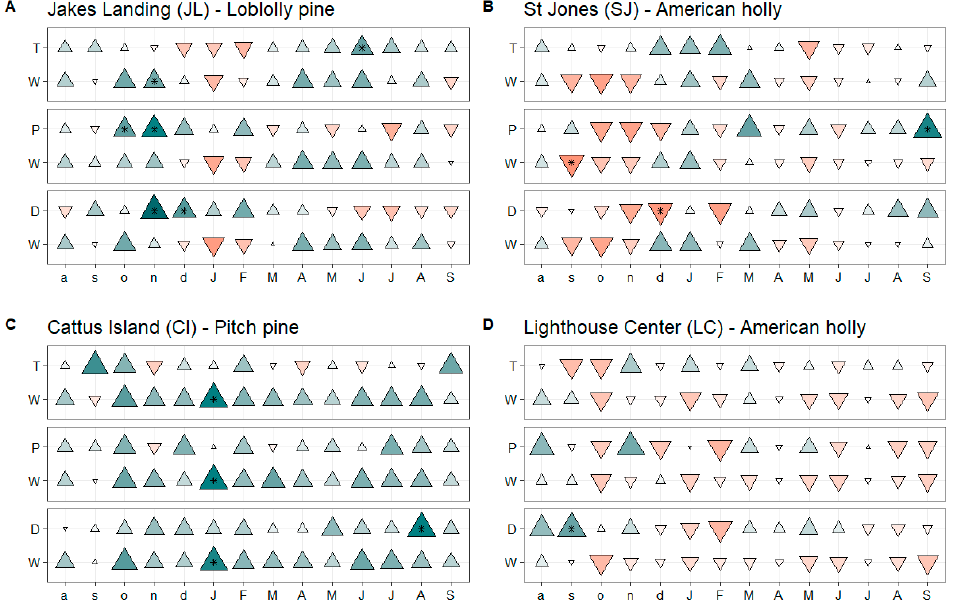
Figure 6. Partial correlation results for chronologies of difference between high and low elevation trees for ( A ) Jakes Landing loblolly pine, ( B ) St. Jones American holly, ( C ) Cattus Island pitch pine, and ( D ) Lighthouse Center American holly. Pairwise tests were temperature (T), precipitation (P), and drought (D) as primary variables and water levels (W) as secondary variables. Positive correlations (upwards, green triangles) represent correlation relationships where high elevation trees grew more, whereas negative correlations (downwards, orange triangles) are where low elevation trees grew more. Saturation and size of symbols reflect the strength of the correlation (i.e., R ), ranging from +0.5 to − 0.5. Significant correlations are noted with an asterisk ( α = 0.05). Antecedent months are given using all lower-case letters, whereas concurrent months are given in capital letters.